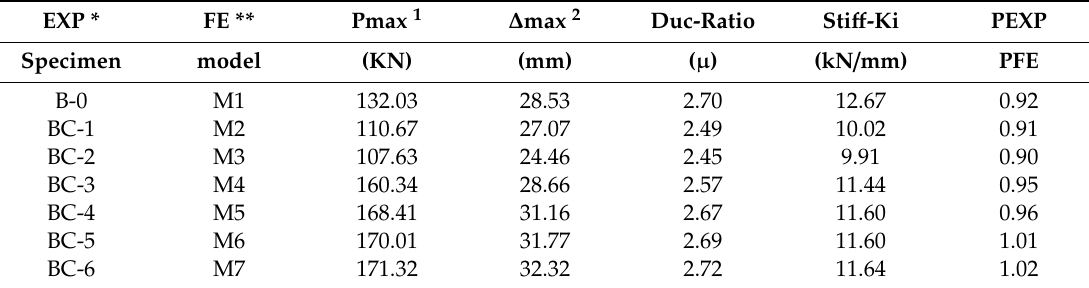
Table 5. Comparison of experimental and FE result for test beams.